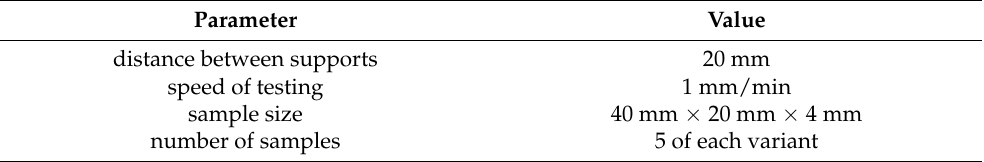
Table 4. Bending strength test’s parameters [24].